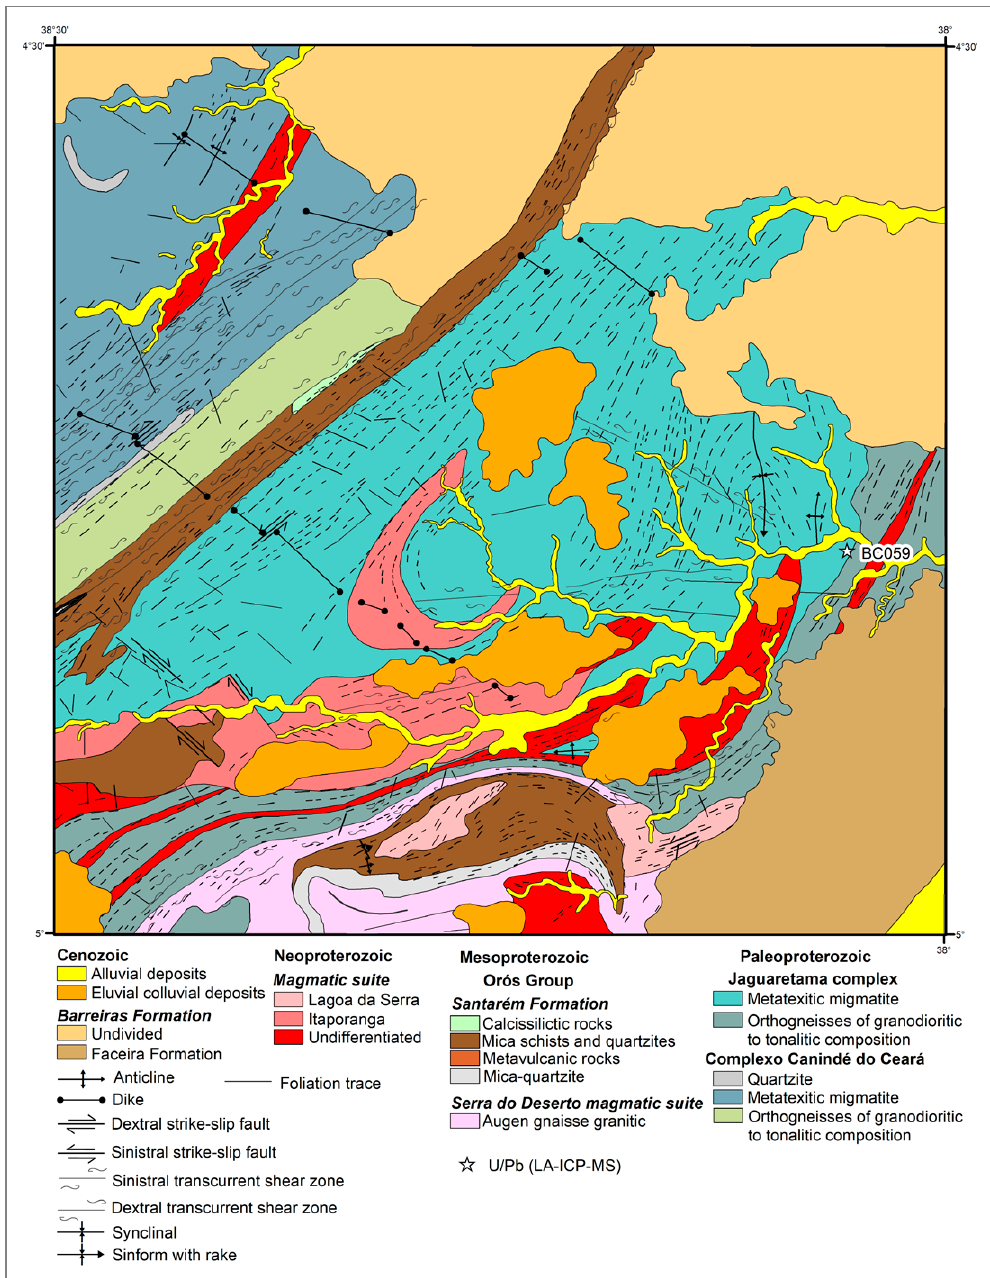
FIGURE 2 – Geological map and sample location (modified from Calado